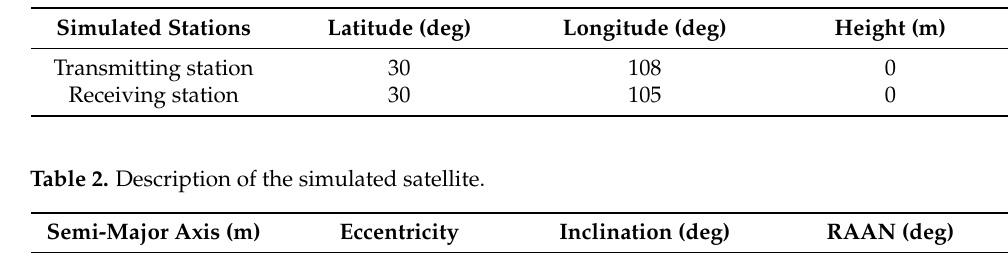
Table 1. Description of two simulated stations.